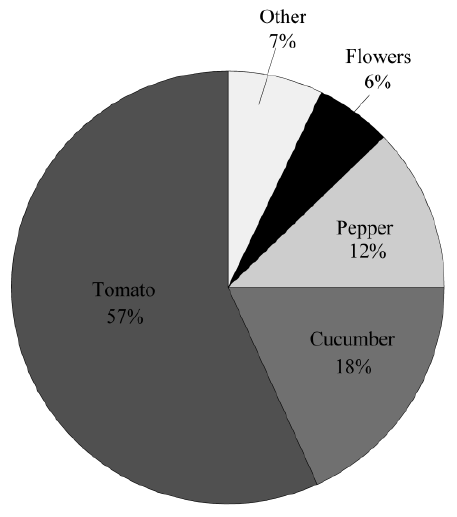
Figure 1. Crop breakdown by area.